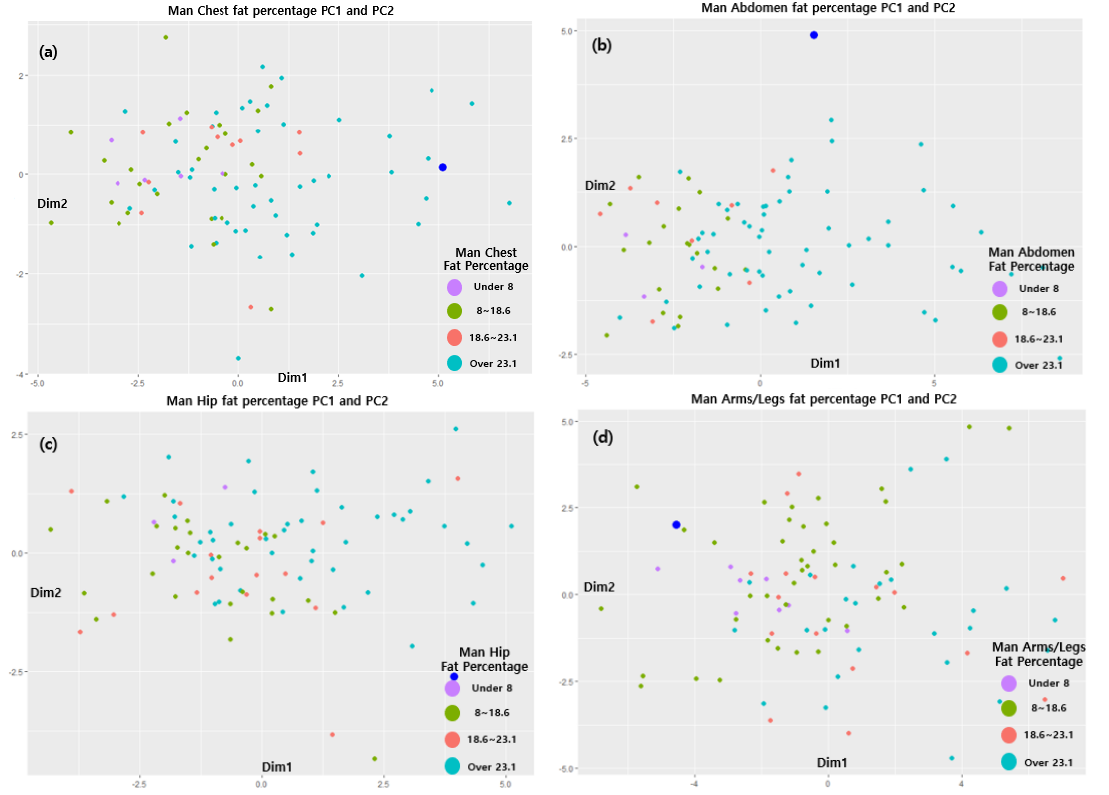
Figure 8. Validation results for the data generated. Table 9. Results obtained with the obesity diagnosis model.